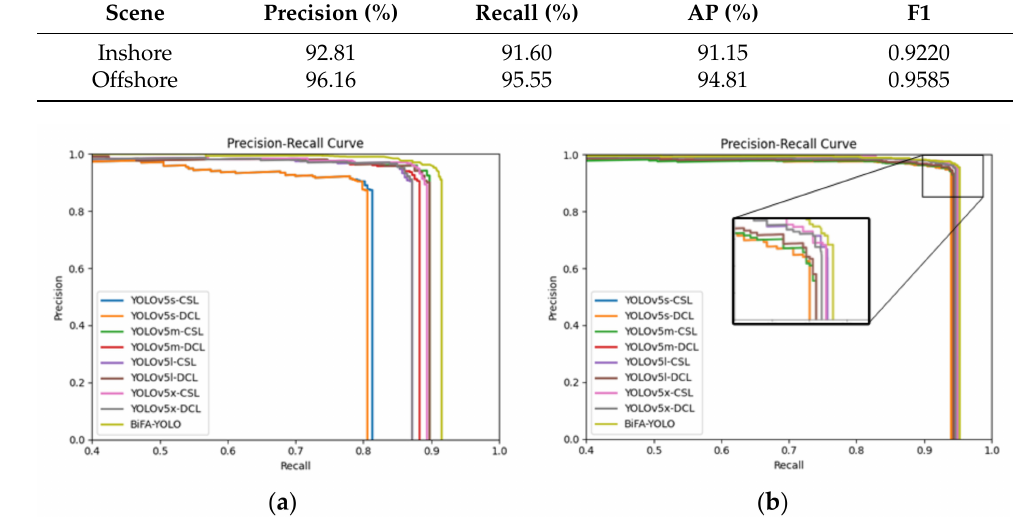
Figure 12. Comparison of curves of different methods in inshore and offshore scene on SSDD. ( a ) PR curves of different methods in inshore scene. ( b ) PR curves of different methods in offshore